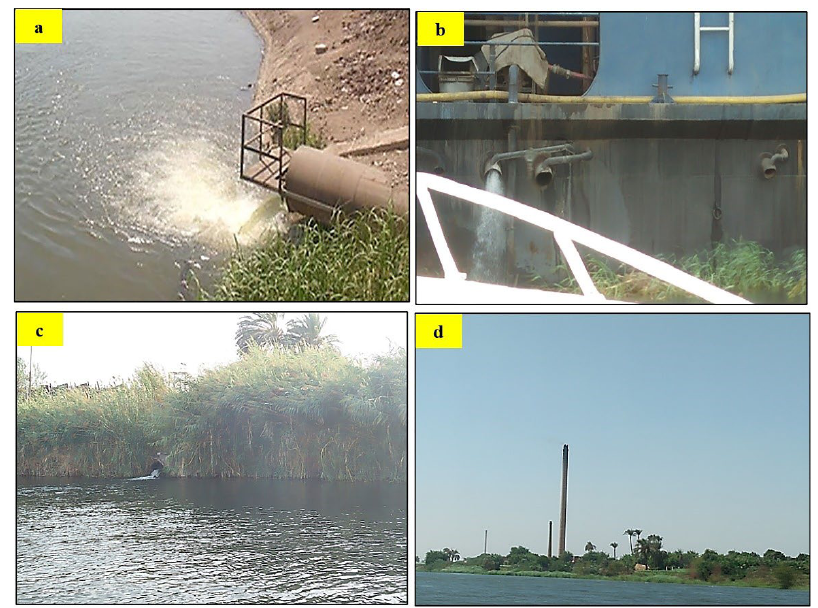
Figure 5. Point anthropogenic sources; ( a ) discharge of sugar refining factory, Giza in Nile River, ( b ) Cruise discharge in the Nile, Sohag, ( c ) Agriculture discharge in Nile, Luxor, and ( d ): Brick fac- tories, Beni Suef on Nile Bank.